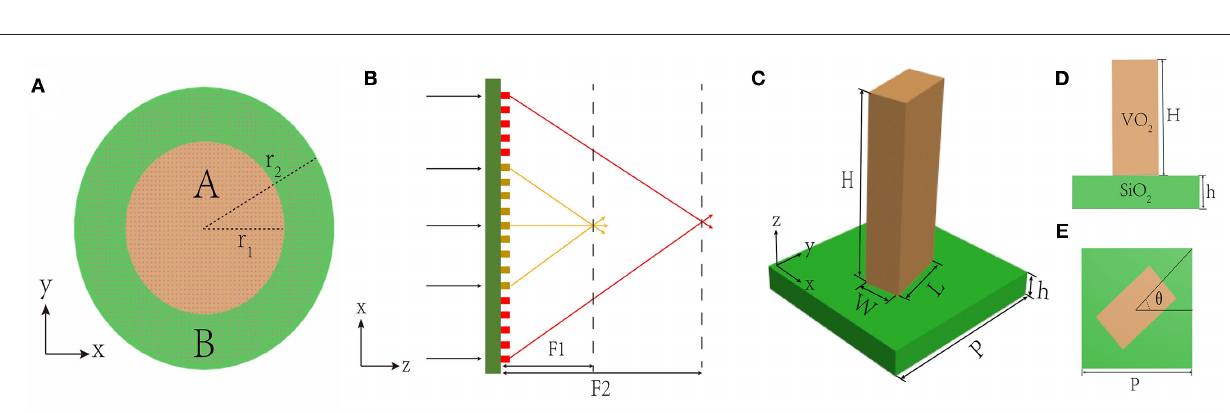
Figure 3A is a schematic diagram of the structure. The lens is composed of two areas, A and B, which are a circle in the area ( 0, r 1 ) and a ring in the area ( r 1 , r 2 ) . Figure 3B